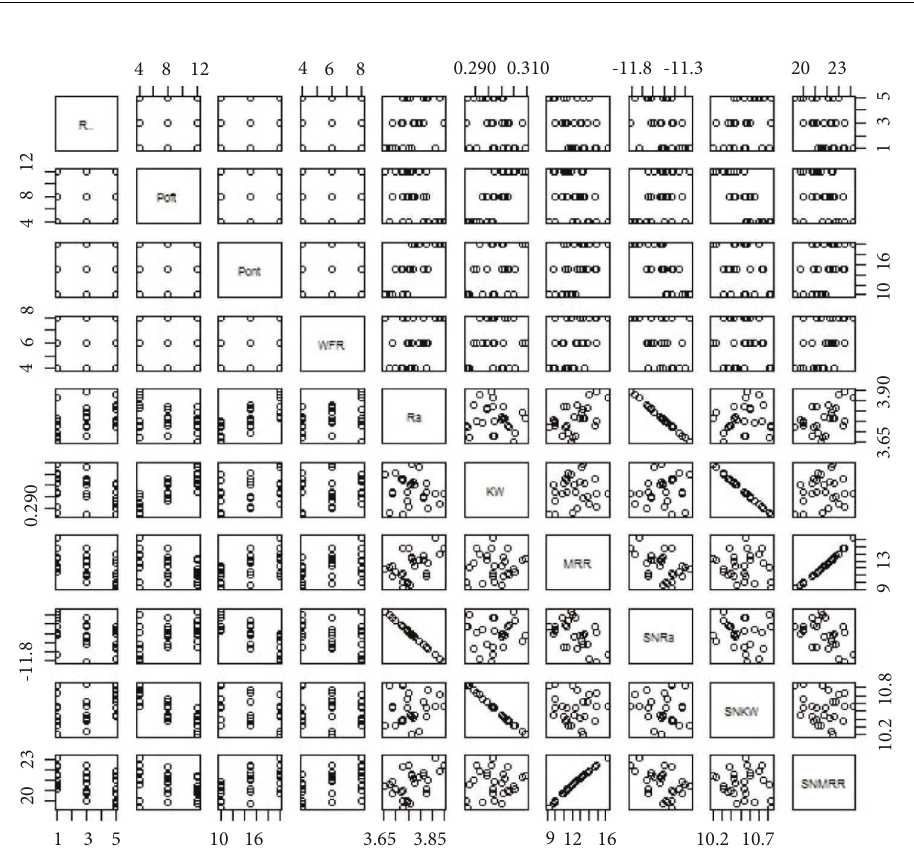
Figure 2: Matrix scatter plot of the L27 OA